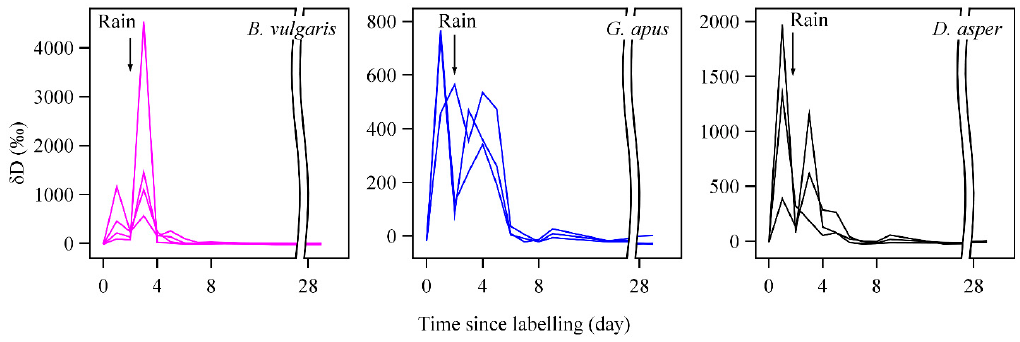
Figure A1. Soil moisture (cm 3 cm − 3 ) and rainfall (mm day − 1 ) in the study period.